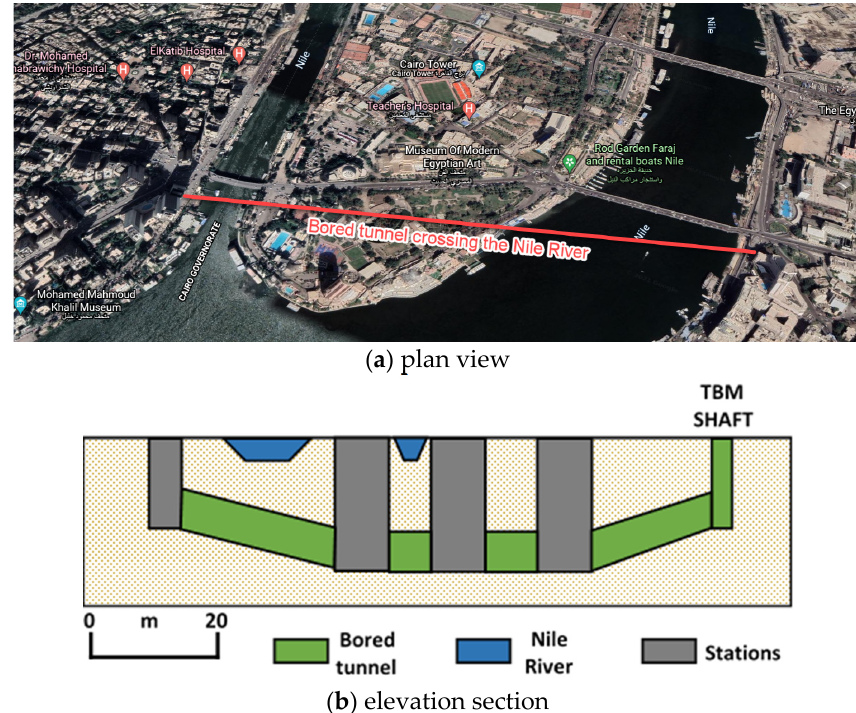
Figure 1. Tunnel layout under the east branch of the Nile River.